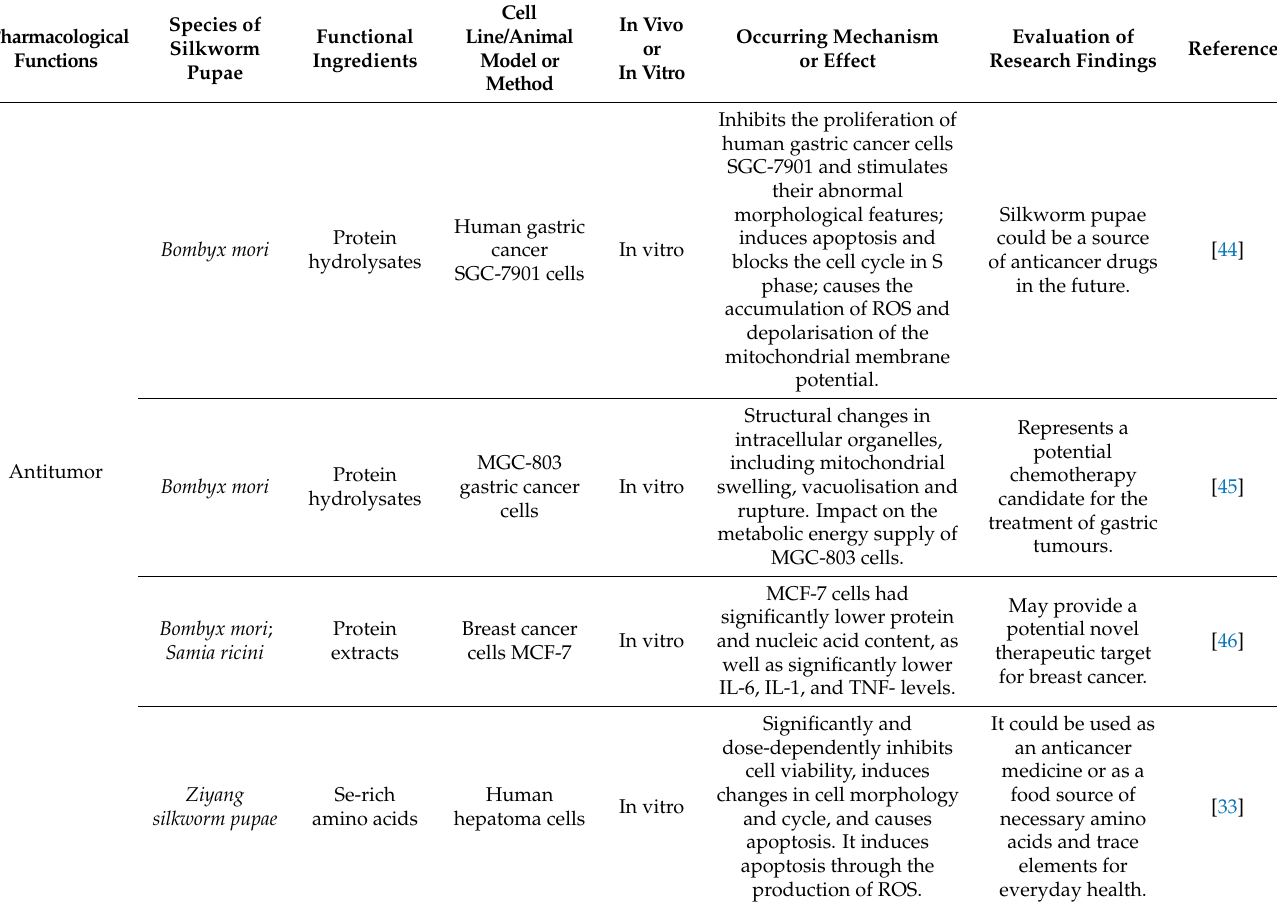
Table 4. Pharmacological functions and mechanisms of occurrence of silkworm